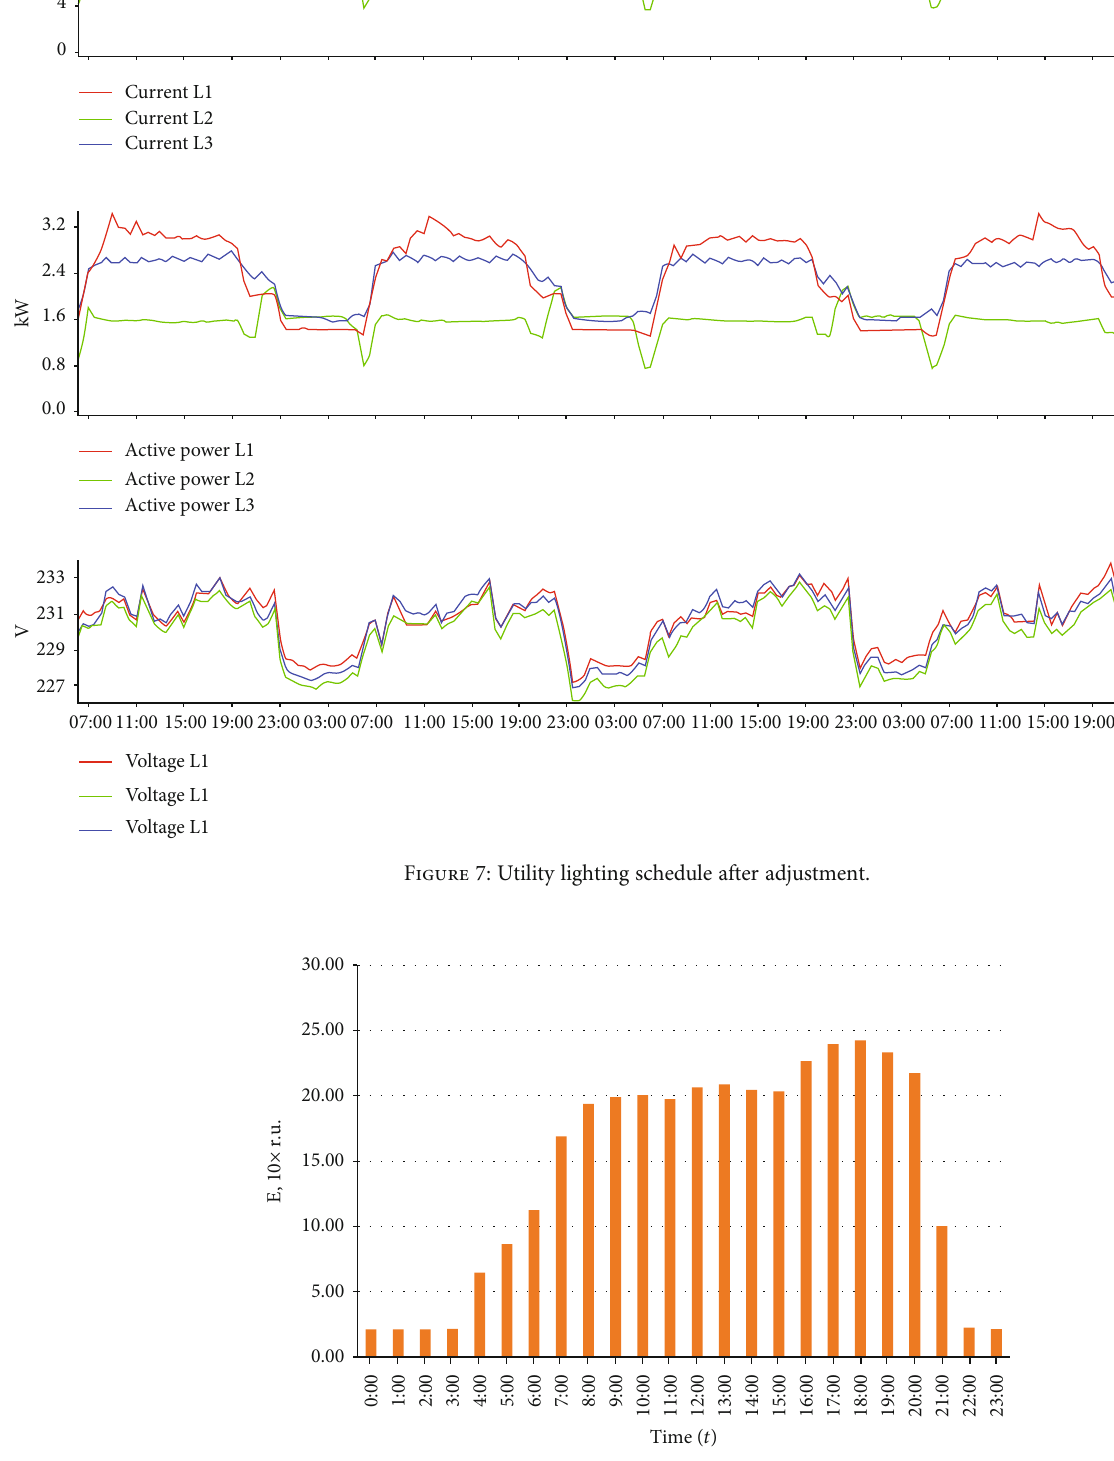
Figure 8: Consumed power of building ’ s communal space